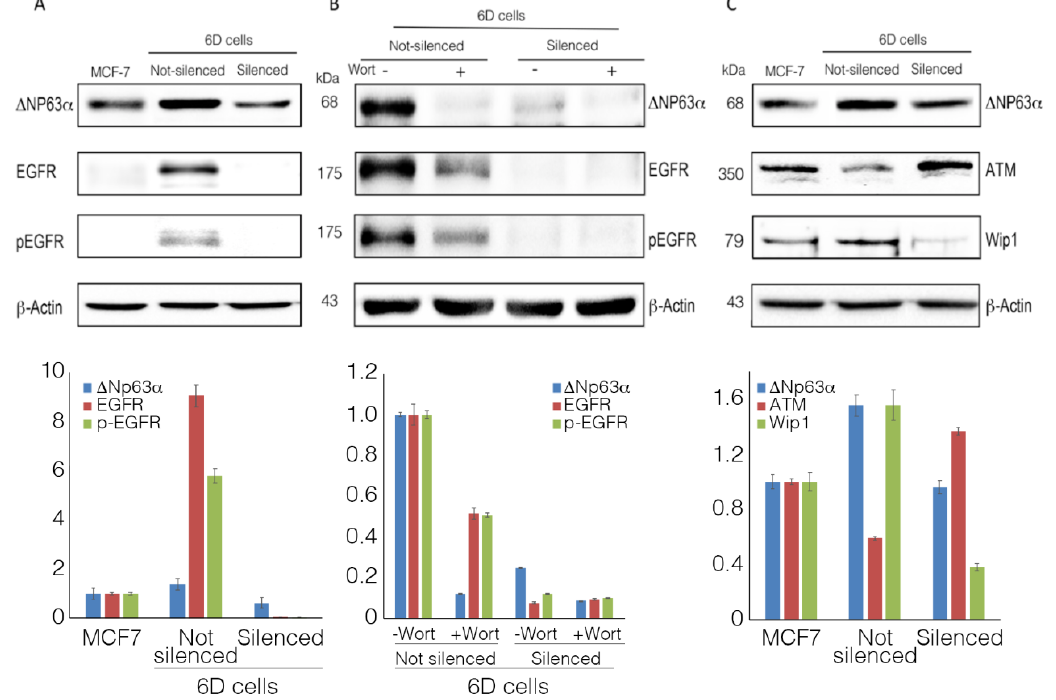
Figure 3. ∆ Np63 α is essential for the expression of epidermal growth factor receptor (EGFR) and phosphatase 1D (Wip1). ( A ) Representative Western blot of EGFR expression and its activated form pEGFR (phosphorylated at Tyr1068) in parental MCF-7cells and in non-silenced and shRNAp63 α -silenced 6D cells. ( B ) Wortmannin’s inhibitory effect on ∆ Np63 α and